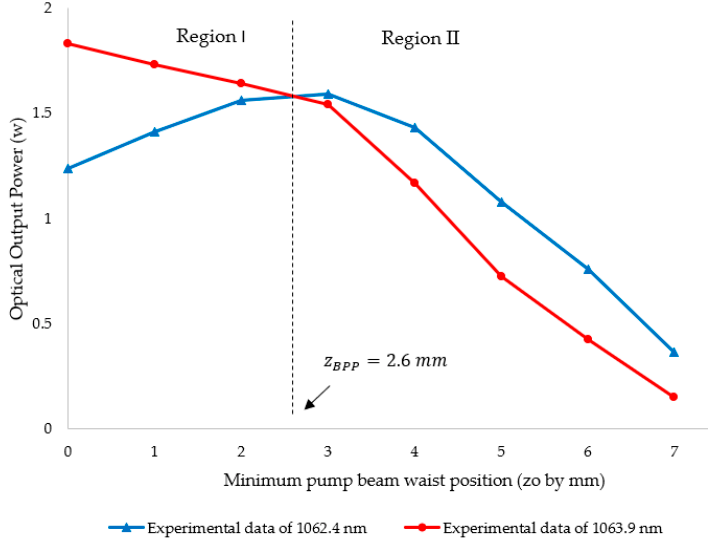
Figure 5. The measured output powers of 1062.4 nm (triangle up) and 1063.7 nm (dots) for σ - π configuration.